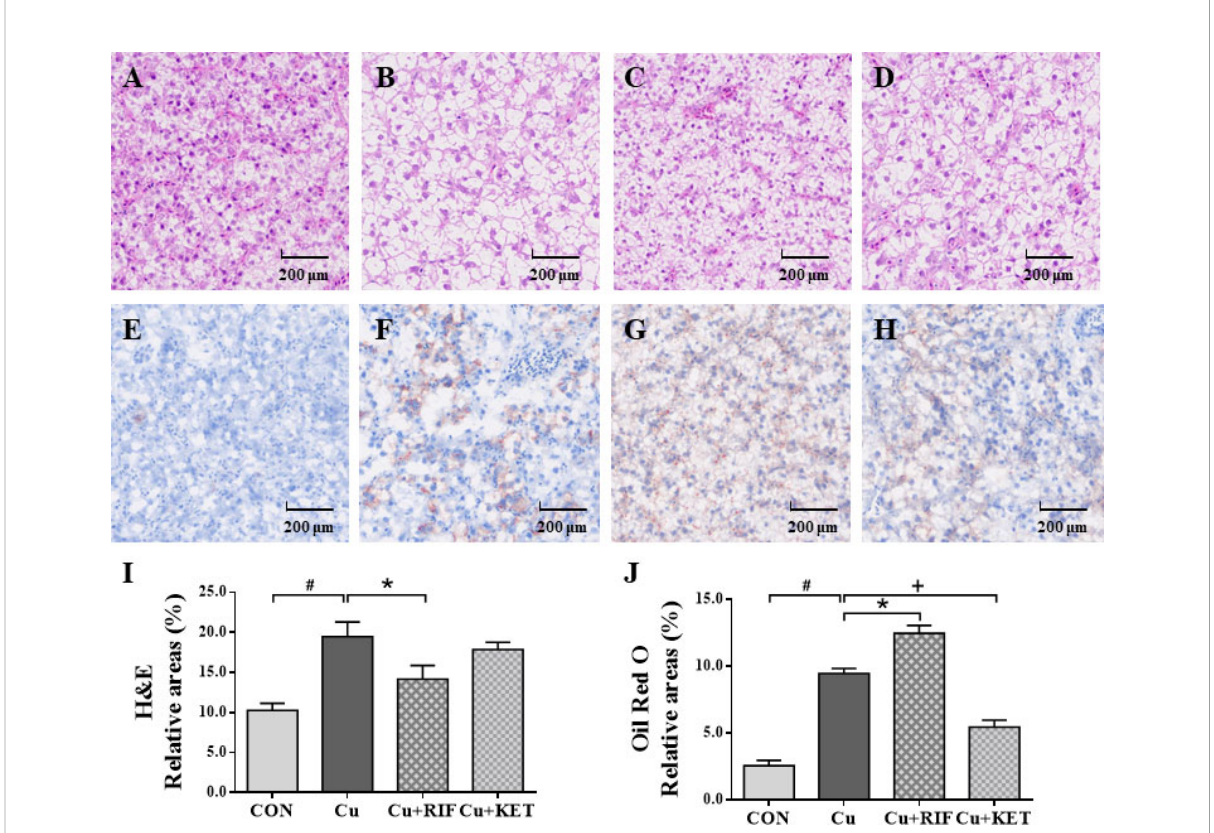
FIGURE 2 Liver histology (H&E) and histochemistry (Oil Red O) observations of largemouth bass subjected to RIF or KET under Cu exposure (n = 6). (A, E) Control; (B, F) Cu exposure; (C, G) Cu+RIF; (D, H) Cu+KET; (I) relative areas of hepatocyte vacuolization; (J) relative areas of lipid droplets. Photomicrographs magni fi cation (× 200) and scale bar (200 m m). H&E: hematoxylin and eosin staining; Oil Red O: Oil red O staining. Lipid droplets was red-colored and nuclei was blue-colored. Data represent means ± SEM and are normalized to percentage of fi eld area. Signi fi cant differences between CON and Cu groups, Cu and Cu+RIF groups, as well as Cu and Cu+KET groups were indicated by “ # ” , “ * ” , and “ + ” ( P <